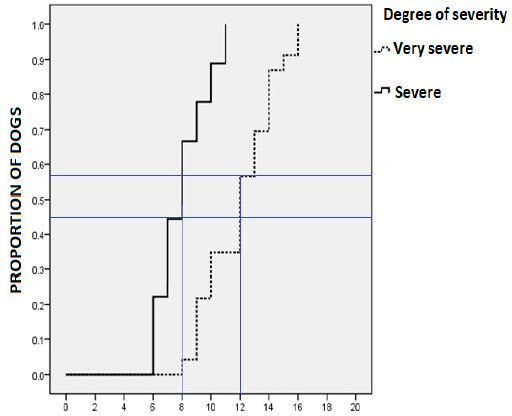
Figure 4. Cumulative proportion of dogs in total remission, according to the degree of initial severity of unresponsive deep-pyoderma.